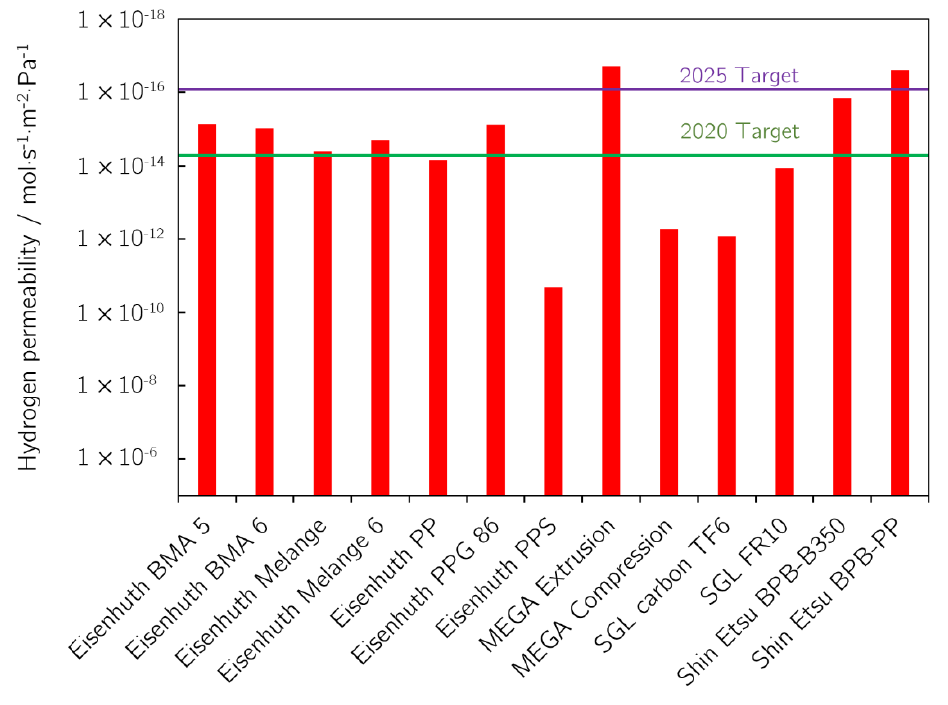
Figure 10. Hydrogen permeability values for BPs tested. DOE 2020 and 2025 target values [23,24] for hydrogen permeability are shown as green and purple lines, respectively.